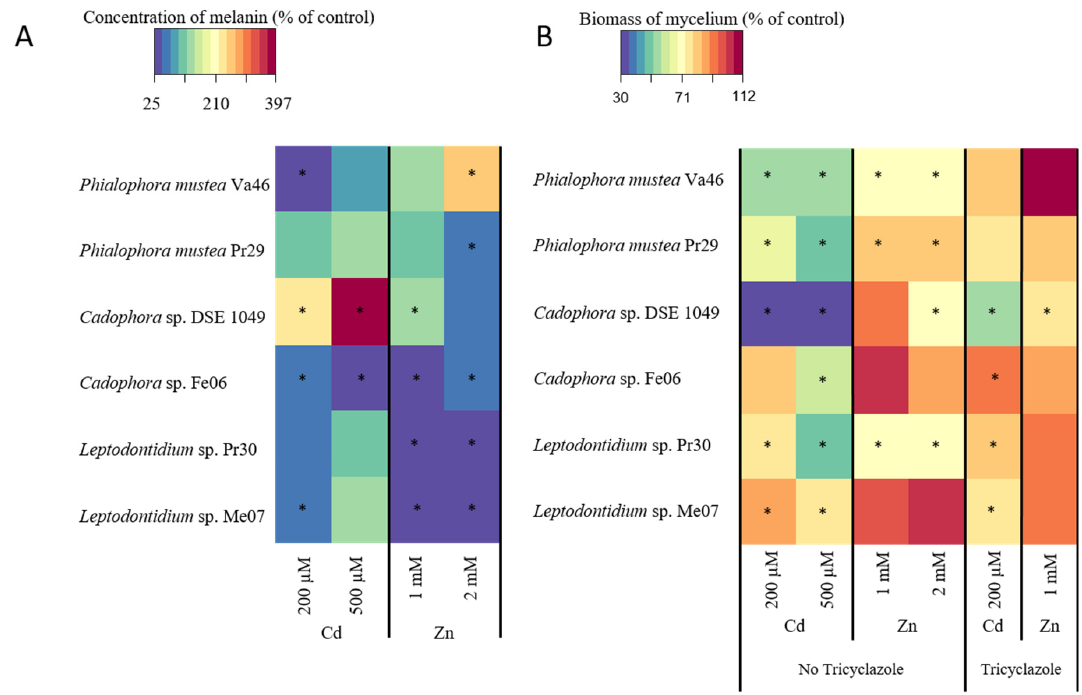
Figure 4. E ff ect of Cd and Zn on melanin accumulation and tolerance of six DSE strains. Relative hyphal melanin concentration ( A ) and relative biomass of DSE mycelia ( B ) in the presence of Cd or Zn in comparison with the control treatment (no TE added). Data are the means of n = 9. The control value of each strain was set to 100%. Within a given DSE strain, significant di ff erences with the respective control treatment are denoted by asterisks (Kruskal–Wallis, p < 0.05).